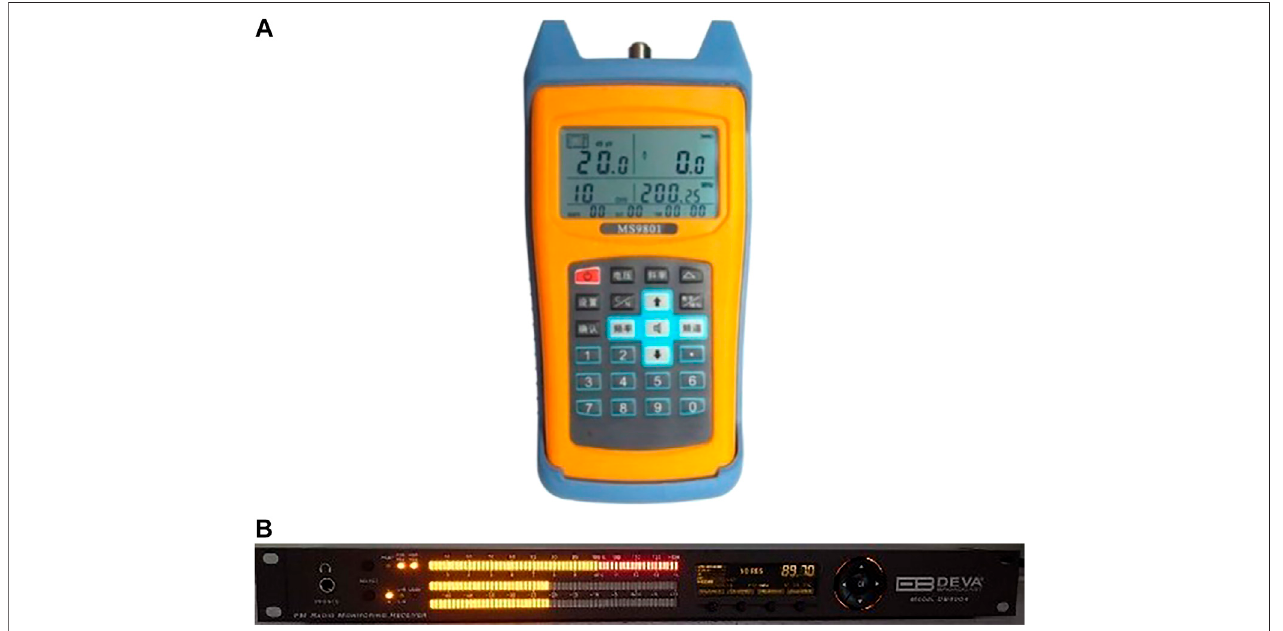
FIGURE 9 | The cumulative error distribution of two different devices. The median positioning error of DB4004 was 0.7 m. The median positioning error of the fi eld strength meter was0.8 m. Smaller dots Per Inch (DPI) device, smaller positioning error.